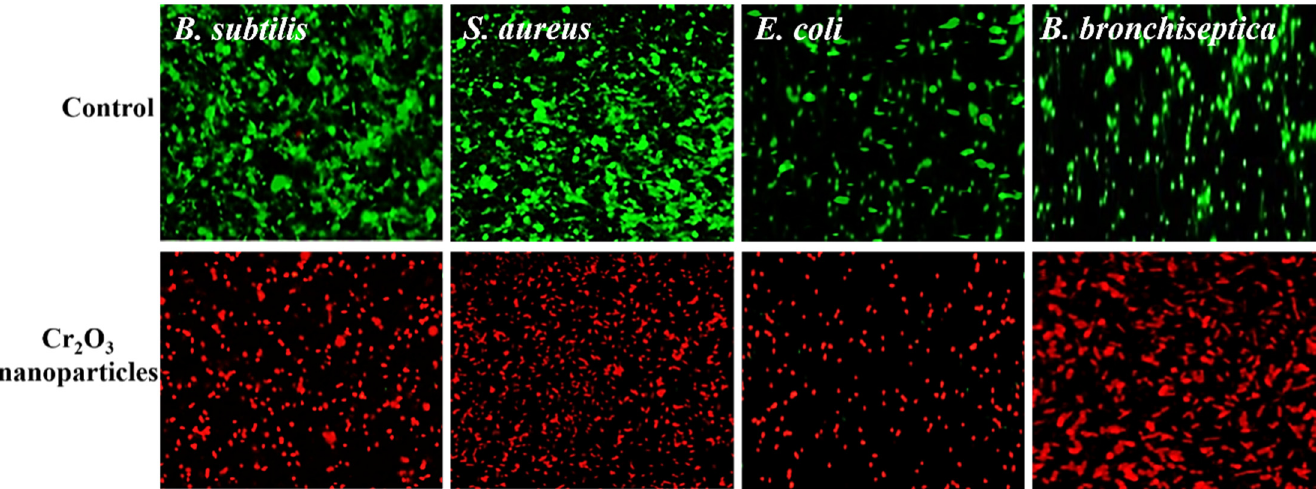
Figure 5. Live/dead bacterial cell images—live cells stained with green (SYTO-9) while dead cells stained with red (PI) (scale bar = 50 µm).